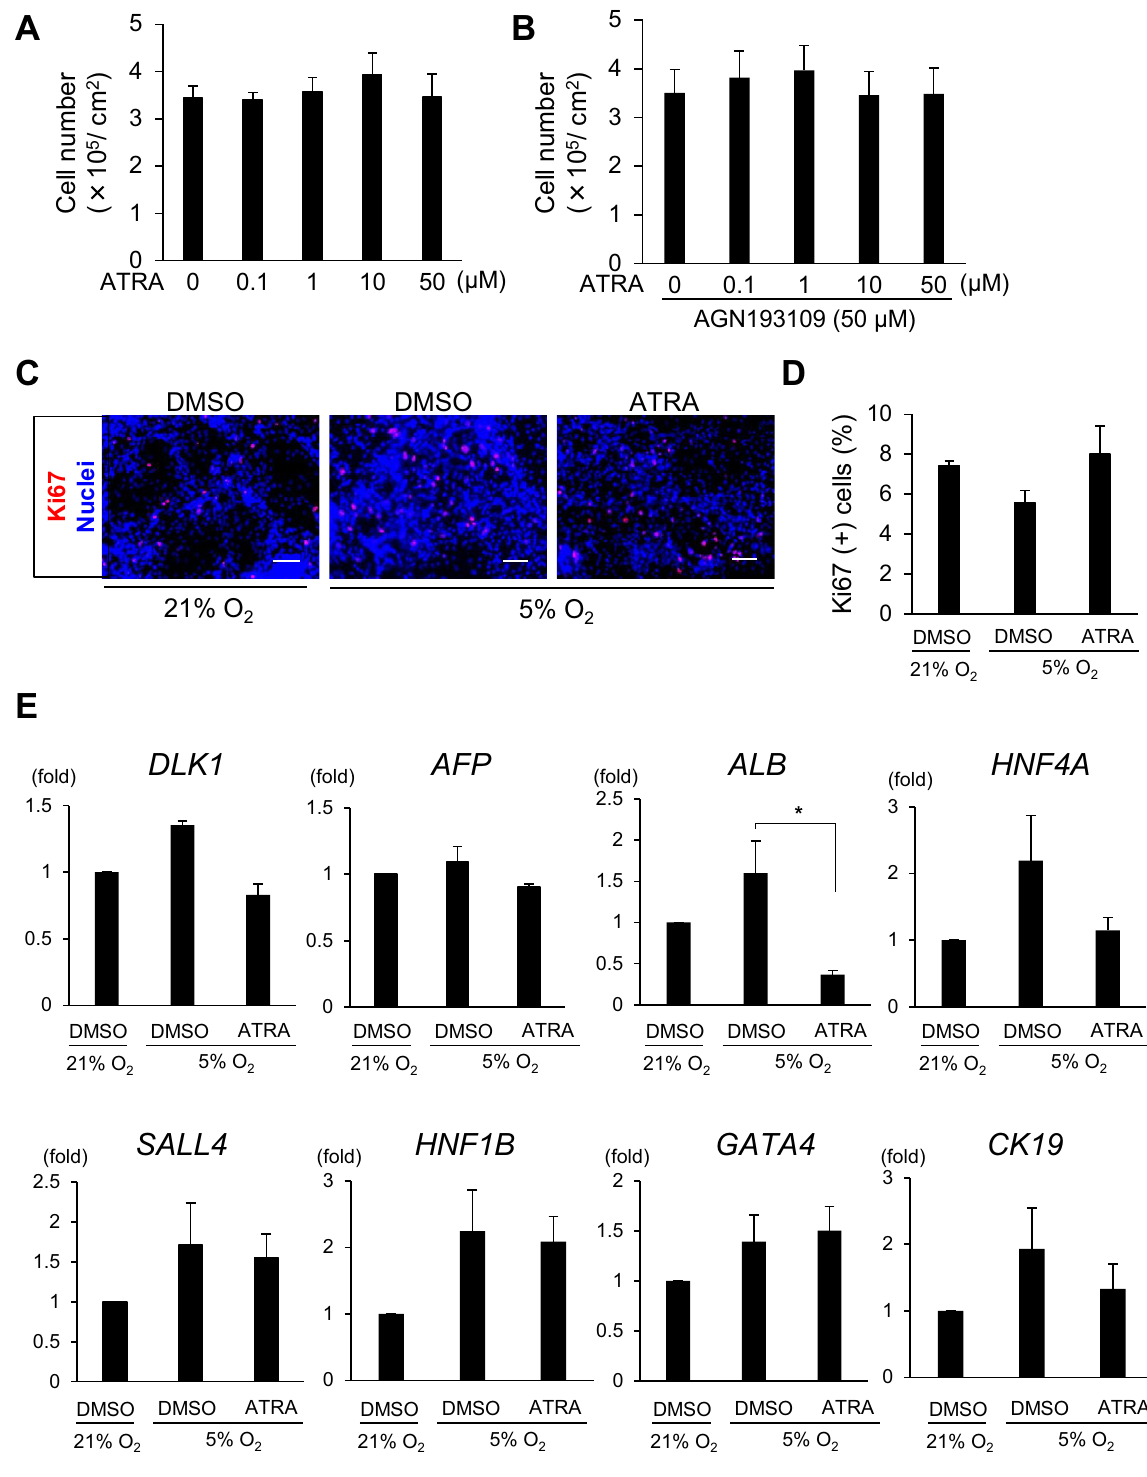
Figure 2. Effects of RA on the proliferation and differentiation of hiPSC-EPO cells. ( A , B ) The numbers of hiPSC-EPO cells after treatment with ATRA alone ( A ) or combined with AGN193109 ( B ) under hypoxic conditions (5% oxygen). ( C ) Immunostaining analysis of hiPSC-EPO cells for a proliferation marker, Ki67. Scale bars 100 μm. ( D ) Percentage of Ki67(+) cells in ( C ). ( E ) qRT-PCR analysis of the expression of the hepatic lineage markers, DLK1 , AFP , ALB , HNF4A, SALL4 , HNF1B , GATA4 and CK19 , by hiPSC-EPO cells treated with DMSO under normoxic (21% oxygen) or hypoxic conditions or with ATRA under hypoxic conditions. The data from three independent experiments (n = 4 for A , B and n = 3 for D , E ) are represented as the means ± SEM in ( A , B , D , E ). Statistical analysis was performed using one-way ANOVA with Bonferroni’s test in ( A , B , D , E ). *p < 0.05 versus the samples treated with DMSO under hypoxic